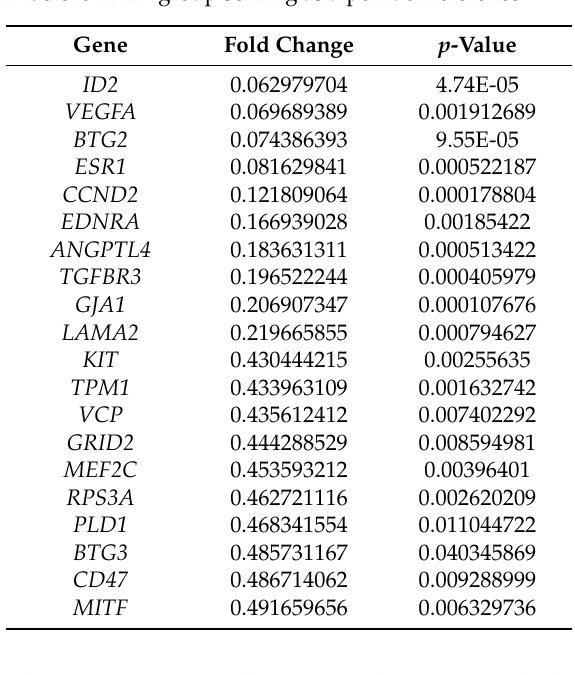
Table 1. Gene symbols, fold changes in expression, and corrected p values of studied genes. All fold changes were calculated as [after in vitro maturation transcript levels/before in vitro maturation transcript levels], with “before IVM” group serving as a point of reference.